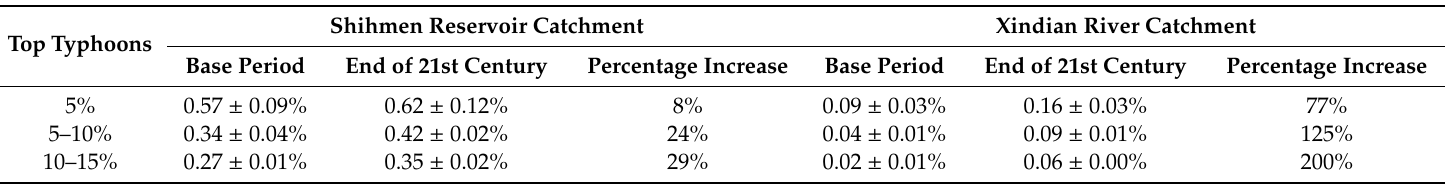
Figure 5. Landslide-area characteristics of the top 5%, 5%–10%, and 10%–15% typhoons during the base period and the end of the 21st century simulated with scenario ensembles. ( a )–( d ) are for the Shihmen Reservoir catchment and ( e )–( h ) are for the Xindian River catchment. Red and blue lines are mean values of landslide-area characteristics, with 95% confidence intervals in red and blue areas, respectively. Table 4. Landslide-area ratio triggered by the top typhoons and its percentage increase during the base period and the last quarter of the 21st century in the Shihmen Reservoir catchment and the Xindian River